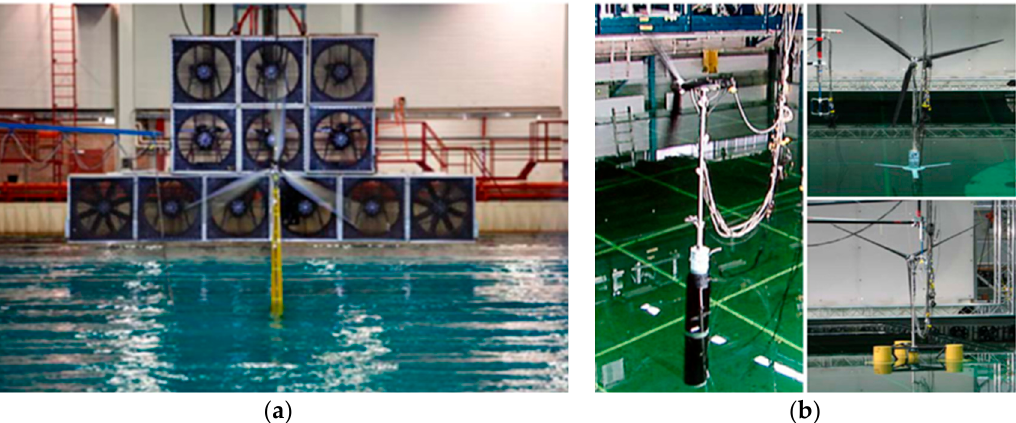
Figure 4. Several typical Froude-scaled model experiments. ( a ) HyWind project (Reprinted/adapted with permission from Ref. [54]. 2006, Skaare, B); ( b ) DeepCWind project (Reprinted/adapted with permission from Ref. [55]. 2014, Koo, B.J.).